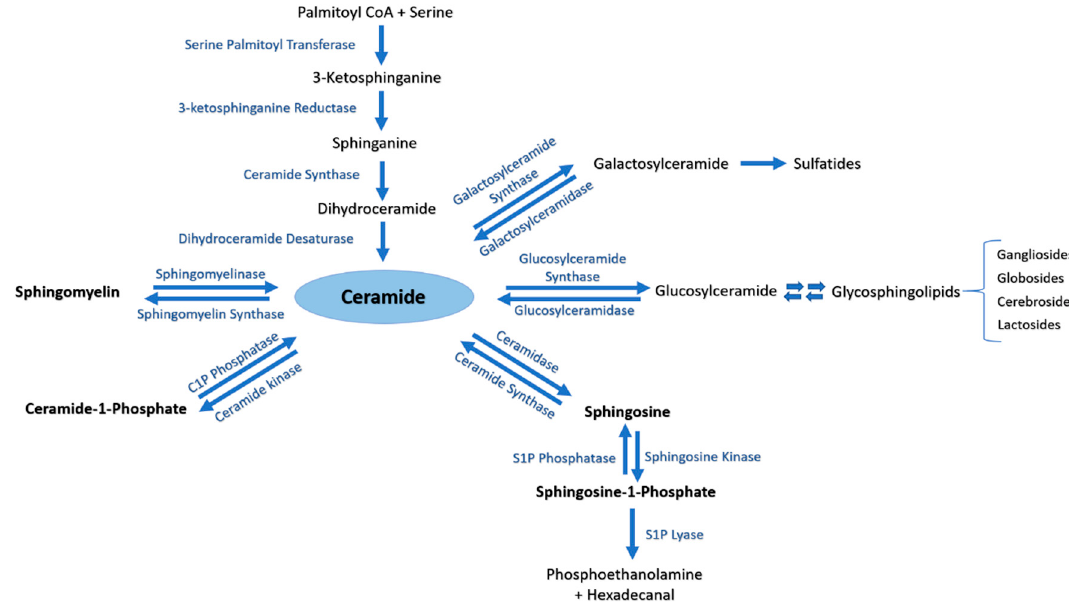
Figure 1. The sphingolipid metabolic pathway. Ceramide is the central metabolite generated in the sphingolipid metabolism by three distinct pathways. Ceramide de novo synthesis consists of Palmitoyl-CoA condensation with serine by the action of serine palmitoyl transferase, followed by a set of reduction and acetylation reactions to generate ceramide. Sphingomyelin (SM) catabolism generates ceramide through the action of sphingomyelinases. The salvage pathway involves N-acylation of fatty acids with a sphingosine backbone to produce ceramide by ceramide synthases. Ceramide can be further phosphorylated to ceramide-1-phosphate (C1P) by ceramide kinase, or converted into complex glycosphingolipids by glucosylceramide or galactosylceramide synthases. Ceramidase is responsible of catabolizing ceramide into sphingosine, which may be further metabolized by sphingosine kinases to generate sphingosine-1-phosphate (S1P).